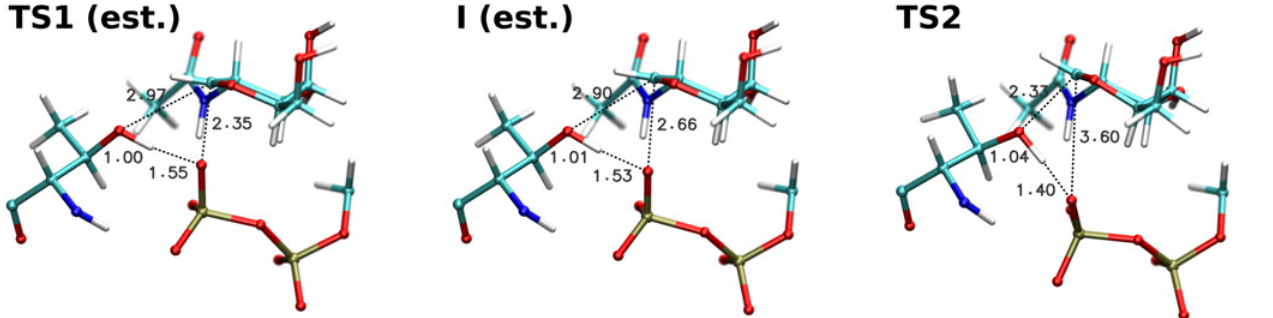
Fig 6. Structures of the estimated first transition state, estimated intermediate and optimized main transition